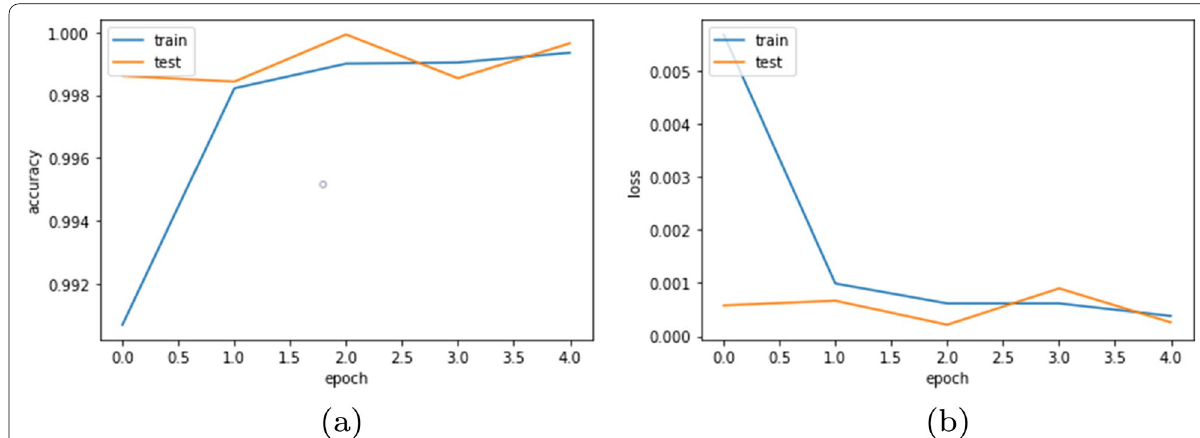
Fig. 5 Graphical Representation of Performance Evaluation of Deep CNN-LSTM